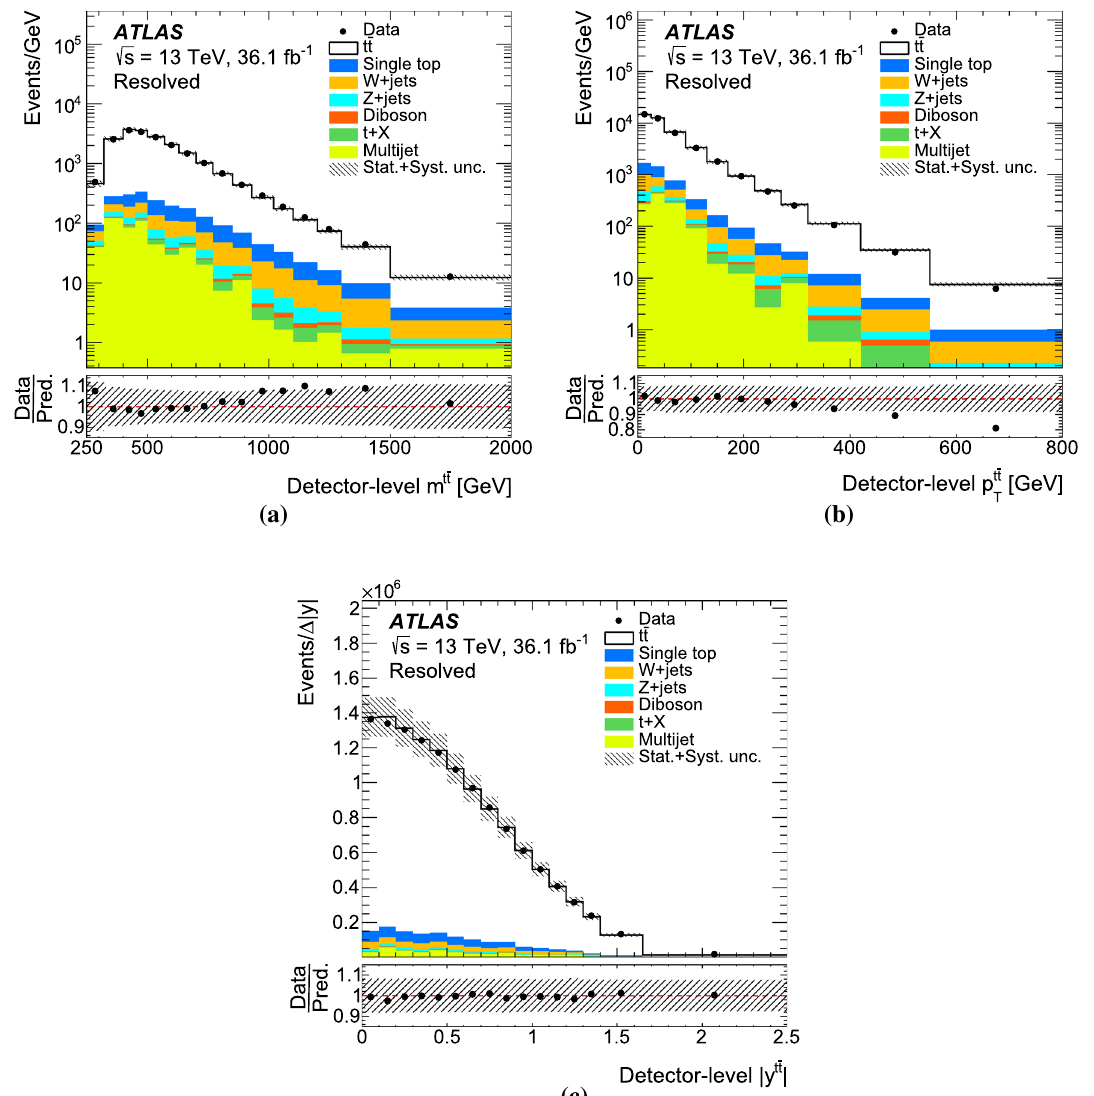
Fig. 7 Distributionsofobservablesinthe (cid:3) + jetschannelreconstructed withthepseudo-topalgorithmintheresolvedtopologyatdetector-level: a invariant mass, b transverse momentum and c absolute value of the rapidity of the t ¯ t system. Data distributions are compared with pre- dictions, using Powheg + Pythia8 as the t ¯ t signal model. The hatched